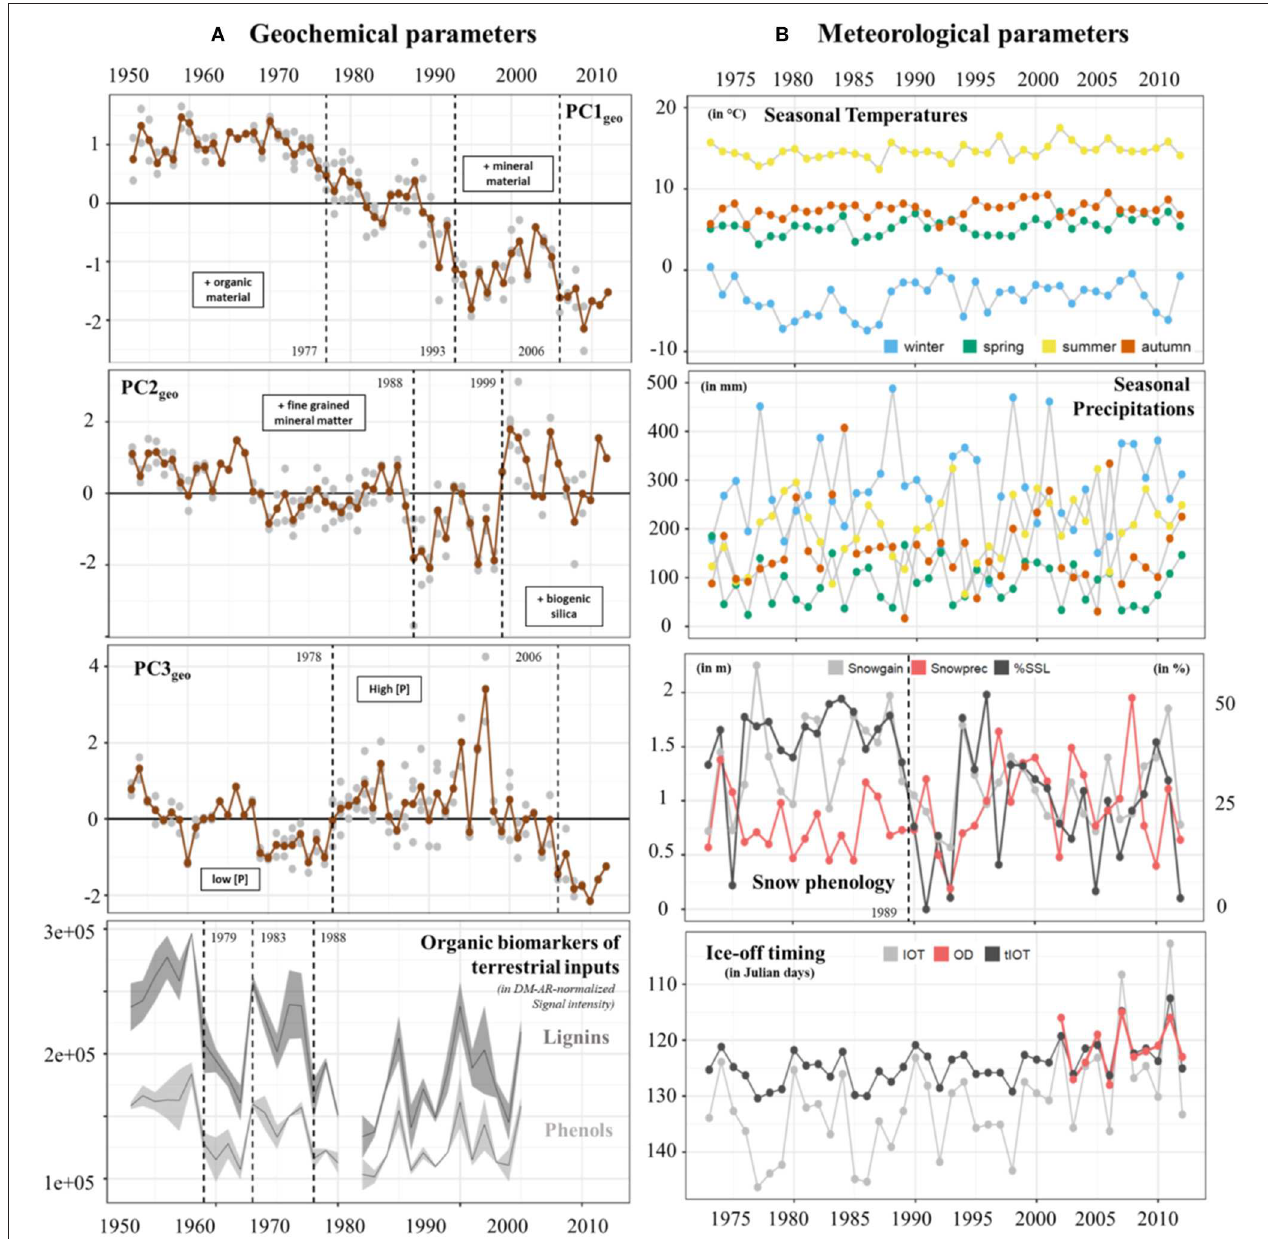
FIGURE 4 | Temporal changes in (A) geochemical parameters: PC1geo, PC2geo, and PC3geo scores over the period 1953-2012 and biomarkers of terrestrial OM (DM-AR normalized signal intensity of lignin and phenolic compounds) over the period 1953–2005 (for each parameter, the lines and bands correspond to the mean value and the standard deviation, respectively). In plots PC1geo, PC2geo, and PC3geo, gray circles indicate PC scores obtained from each sample for the seven sediment cores while brown circles indicate the mean values of PC scores for each year. Main differences between positive and negative values of the 3 axis were described by the keywords within boxes. (B) Meteorological parameters including seasonal mean air temperature (in ◦ C), seasonal sum precipitation (in mm), total snow gain (Snowgain in m), sum of precipitation during snowfall days (Snowprec in m), percentage of spring snow loss (SSL in %), and the timing of lake ice-off (OD, observed data; IOT, modeled data; tIOT, transformed modeled data, in Julian days) over the period 1973–2012. Change points are indicated by dashed lines. For the snow phenology panel, the dashed line corresponds to the %SSL values.